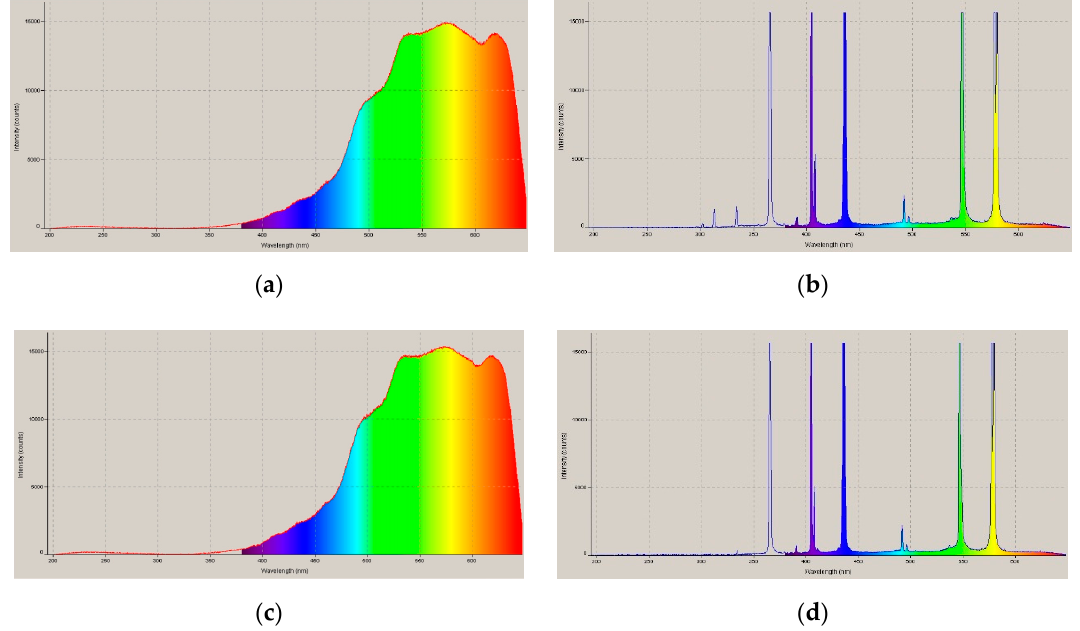
Figure 4. Spectraobtained by applying two UV light sources.( a ) Original spectra of 70W bulb, ( b ) original spectra of 300W bulb, ( c ) spectra after passing the desiccator glass, 70 W bulb, and ( d ) spectra after passing the desiccator glass, 300W bulb.